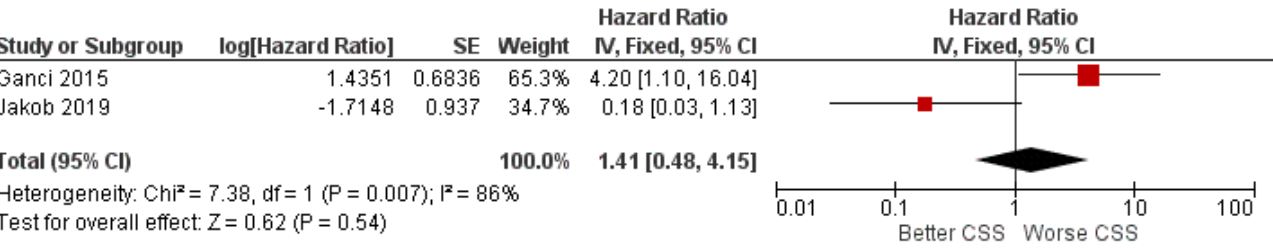
Figure 6. Funnel plot for the primary outcome; I 2 = 60%. We also used GRADE pro-GDT to assess the quality of the primary outcome (Table 3). The results suggest that the quality of the evidence is moderate for the primary out- come.